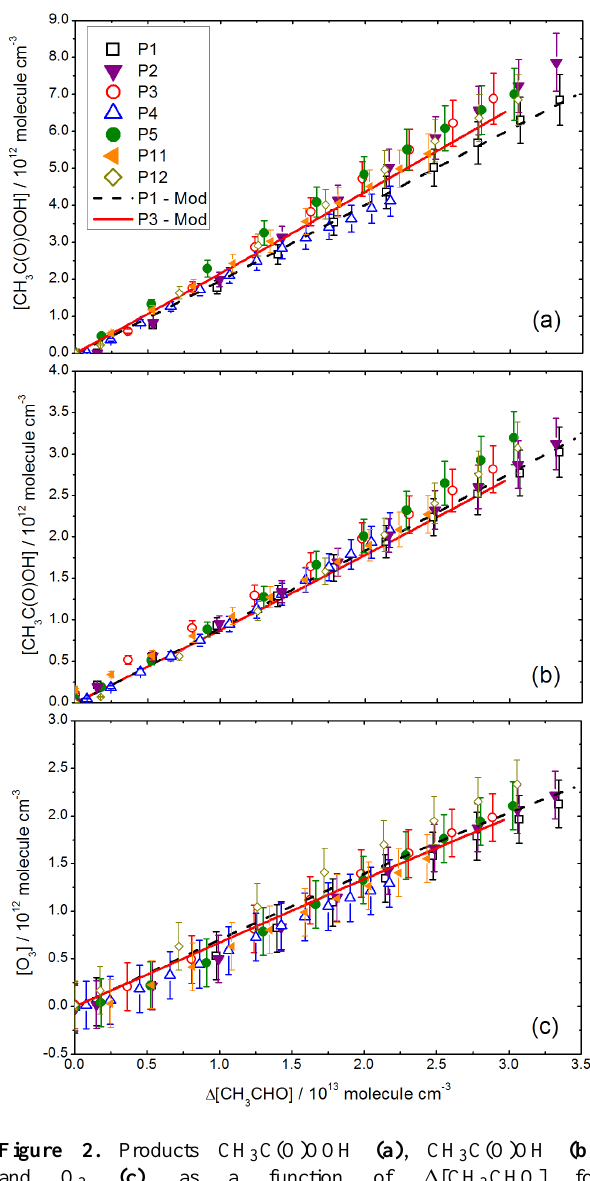
Figure 2. Products CH 3 C(O)OOH (a) , CH 3 C(O)OH (b) , and O 3 (c) , as a function of (cid:49) [CH 3 CHO] for [CH 3 OH] 0 :[CH 3 CHO] 0 ≈ 4 in air at 1000mbar and 293K for runs P1–P5, P11 and P12. Good agreement was observed between experimental data and the chemical model for all data sets with k (R5) = 2 . 4 × 10 − 11 cm 3 molecule − 1 s − 1 and average determined yields of α (R5a) = 0 . 37 ± 0 . 10, α (R5b) = 0 . 12 ± 0 . 04 and α (R5c) = 0.51 ± 0.12. Only model runs for experiments P1 and P3 are shown as examples, the optimised branching ratios thereof are shown in Table 1. All uncertainties quoted to ± 1 σ